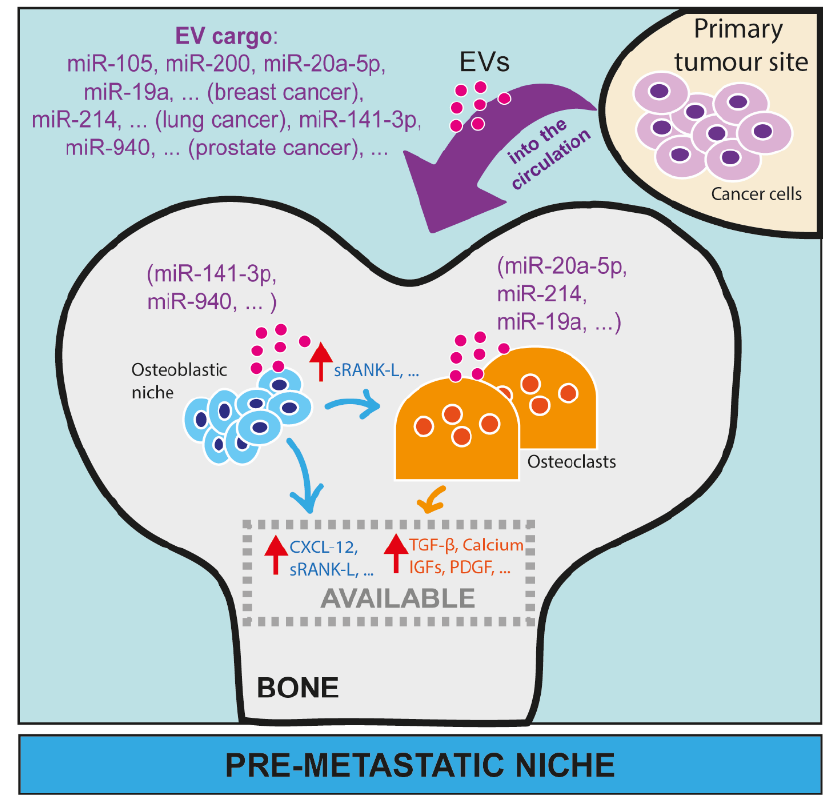
Figure 3. The role of microRNAs in the pre-metastatic niche in bone. MiRNAs have been largely investigated as EV cargo from cancer cells able to remotely affect the activity of cells in distant organs, such as osteoblasts and osteoclasts in bone. Here, we reported some examples of miRNAs from breast cancer (miR-105, miR-200, miR-20a-5p, miR-19a, etc.), lung cancer (miR-214, etc.) and prostate cancer (miR-141-3p, miR-940, etc.) that, as EV cargo, can circulate in blood or lymphatic vessels and reach distant sites, such as bone. In bone, EVs can be taken up by osteoblasts (e.g., miR-141-3p, miR-940) or osteoclasts (e.g ., miR-20a-5p, miR-214, miR-19a), and modulate their activity and/or